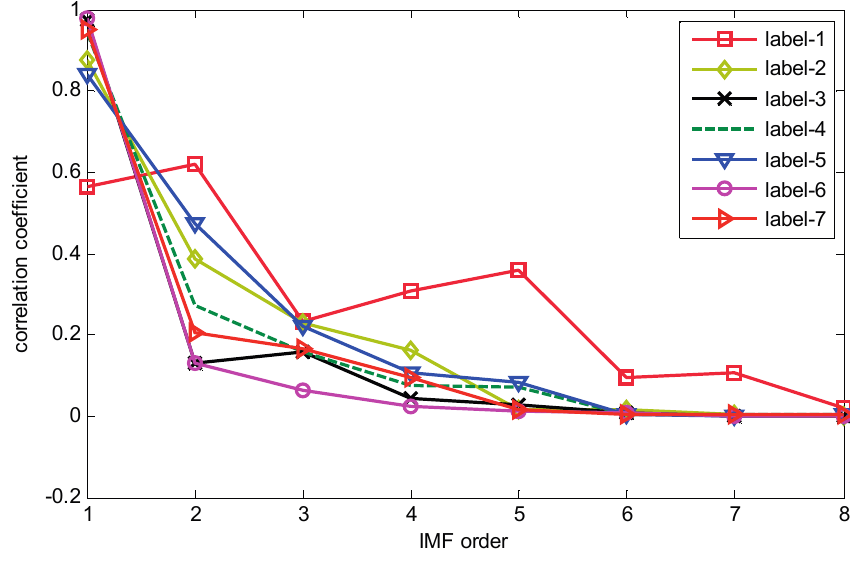
Figure 2. Correlation coefficient between IMF component and original vibration signal.